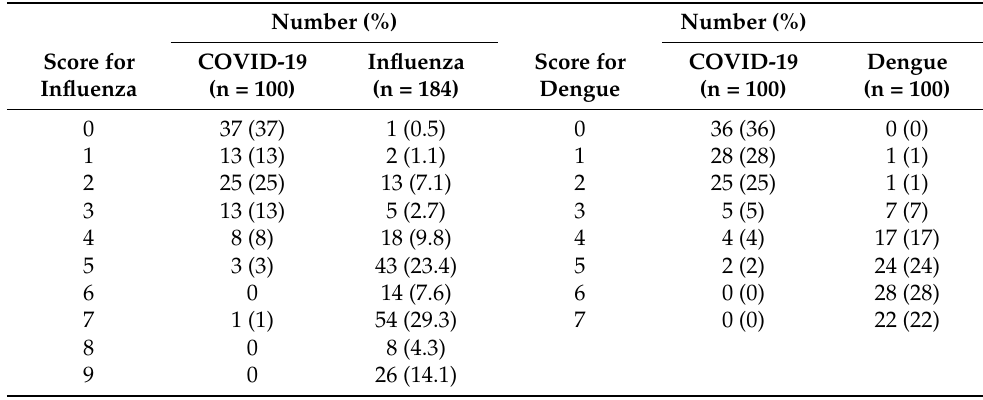
Table 7. Accuracy of total score for influenza/RSV and dengue.